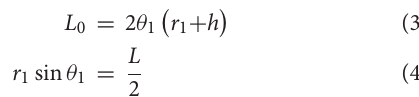
(TPU)-coated nylon fabric. Three sheets of textile are used